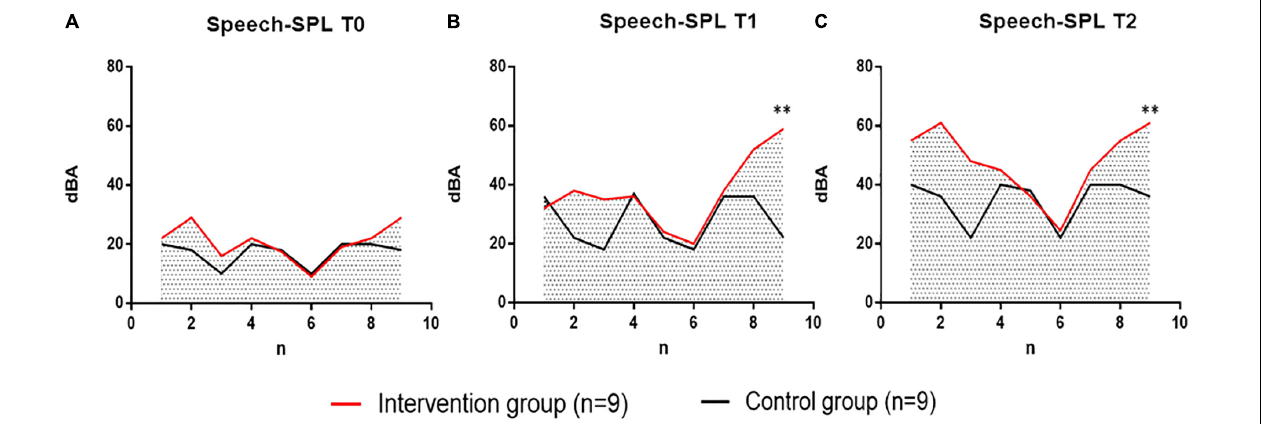
FIGURE 6 | Comparison of voice pressure levels (Speech-SPL, dBA) at T0, T1, and T2 between the intervention group receiving vocal phonation therapy (VIT) and the control group receiving breathing pronunciation training. Intervention Group, intervention group, in red. The Control group is in black. (A) The individual difference distribution of Speech-SPL values between patients in the intervention group ( n = 9) and patients in the control group ( n = 9) at T0 time point. (B) Individual difference distribution of Speech-SPL values at T1 time between patients in the intervention group ( n = 9) and patients in the control group ( n = 9). (C) Individual difference distribution of Speech-SPL values at T2 time points between patients in the intervention group ( n = 9) and patients in the control group ( n = 9). dBA, decibels; N, Number of subjects; T0, baseline; T1, 6 weeks later; T2, 12 weeks later. ∗∗ P < 0.01, the difference between groups was extremely significant.